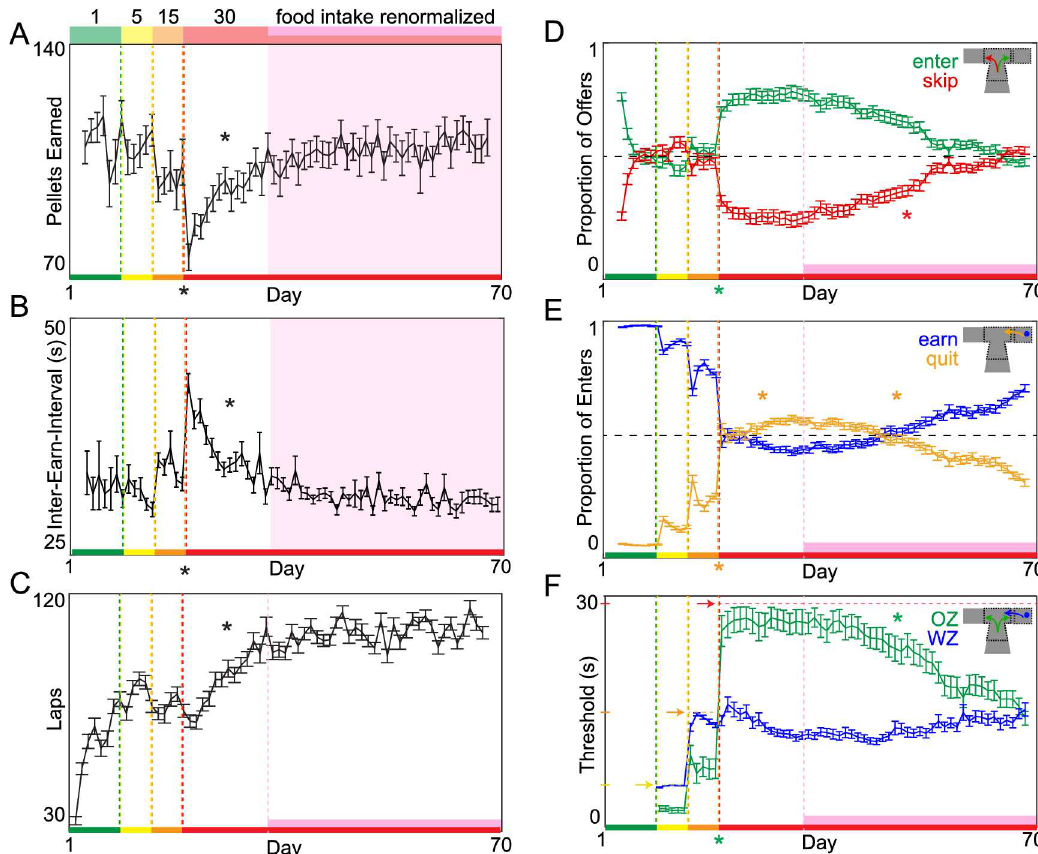
Fig 2. Changes in economic decisions in an increasingly reward-scarce environment. (A-B) Primary dependent variables: total earned food intake (A) and reinforcement rate (B), measured as average time between earnings. Transition to the 1–30 s block caused a significant decrease in food intake and reinforcement rate. By approximately day 32, food intake and reinforcement rate renormalized back to stable baseline levels compared to previous testing in reward-rich environments. The epoch marked in pink defines this renormalization to baseline and is used throughout the remaining longitudinal plots. (C) Number of self-paced laps run (serially encountering an offer in each of the 4 restaurants). (D) Proportion of total offers entered versus skipped. Horizontal dashed line represents 0.5 level. (E) Proportion of total enters earned versus quit. Horizontal dashed line represents 0.5 level. (F) Economic decision thresholds: OZ and WZ choice outcomes as a function of cost. Horizontal dashed lines represent the maximum possible threshold in each block. Data are presented as the cohort’s ( N = 31) daily means ( ± 1 SE) across the entire experiment. Color code on the x-axis reflects the stages of training (offer cost ranges denoted from 1 to the number on the top of panel A). Vertical dashed lines (except pink) represent offer block transitions. (cid:3) on the x-axis indicates immediate significant behavioral change at the block transition; otherwise, (cid:3) indicates gradual significant changes within the 1–30 s block during either the early 2 wk adaptation period or late pink epoch. Data available as a supplemental file. OZ, offer zone; WZ, wait zone F = 151.65, p < 0.0001; offer zone versus wait zone: F = 59.85, p < 0.0001). Furthermore, we